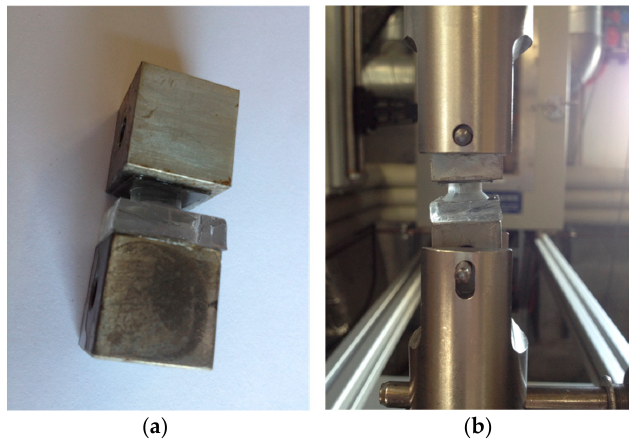
Figure 5. Tensile strength test for the bonding. ( a ) Test sample was fixed between the two metal parts from the tensile test machine for the tensile strength test. ( b ) A sample during the test.